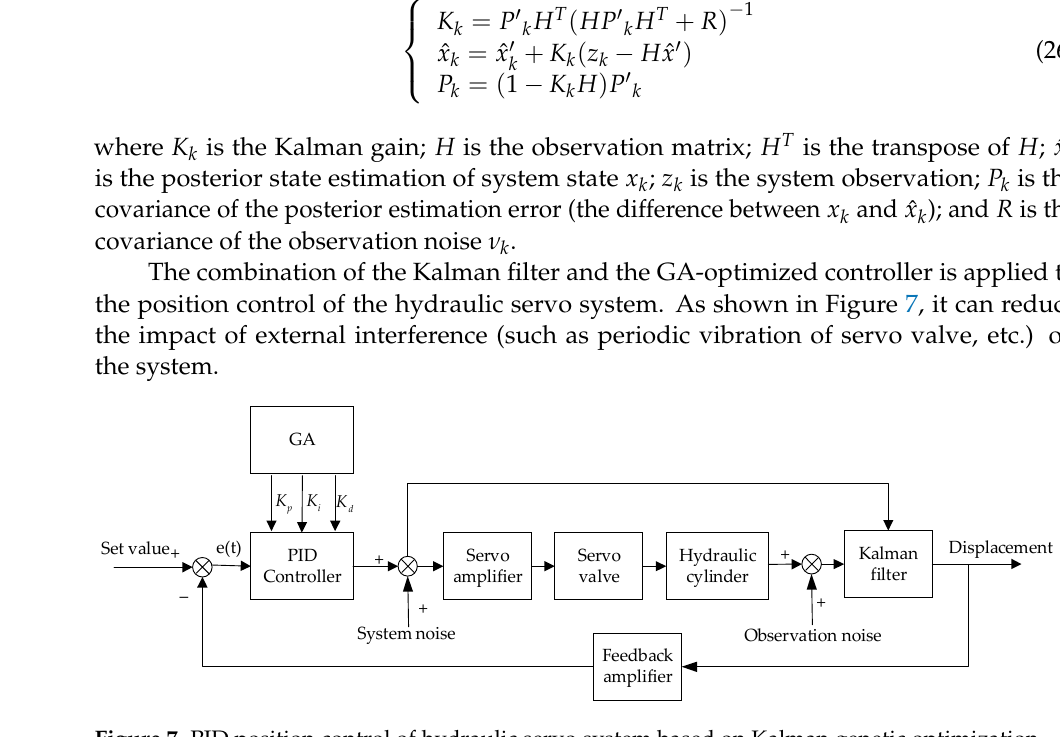
Table 2. Parameter values of ordinary PID and GA-optimized PID.